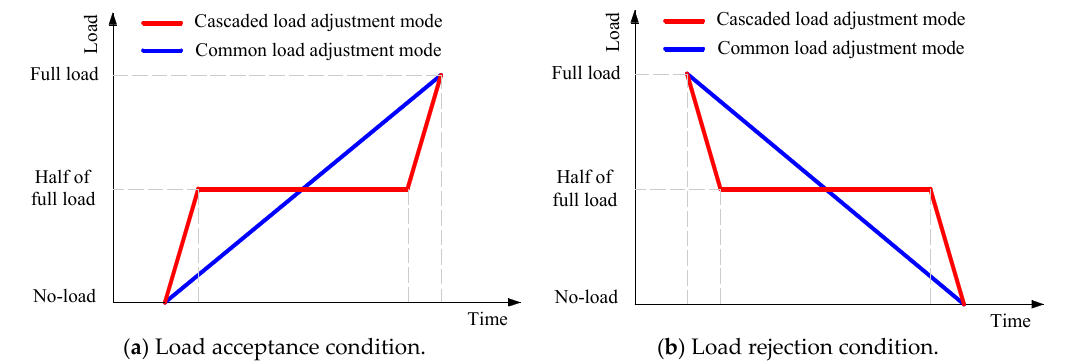
Figure 11. Schematic of load change processes under different load adjustment modes [64].